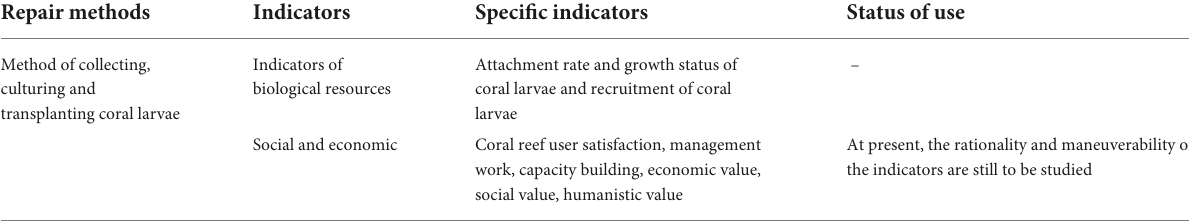
TABLE 2 Common evaluation indicators of coral reef ecological restoration effectiveness.